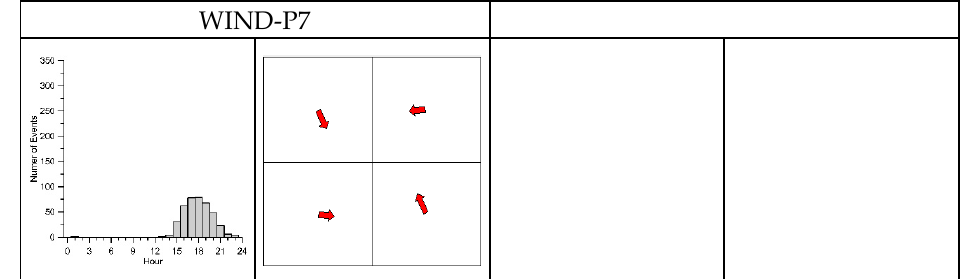
Figure 8. Wind circulation patterns in the Mexico City region during the period 2001–2010. For each pattern, we presented the hourly population (left) and the mean wind velocity (relative to the pattern) at the city quadrants (right). The size of red arrows that stand in for the velocity vectors indicates the velocity magnitude in a scale relative to the edge size of the squares that represent the quadrants.